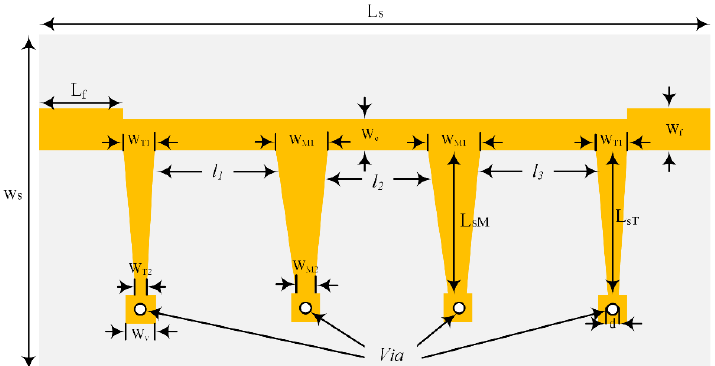
Figure 6. Layout of the proposed microstrip UWB bandpass filters with tapered resonators. Table 2. Dimensions of the elements of the designed filters